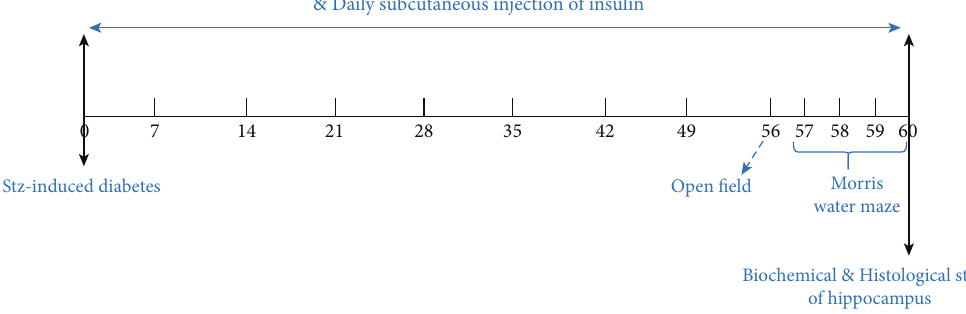
Figure 1: An illustration of the experimental protocol for rats receiving insulin, WJMSC-CM, or